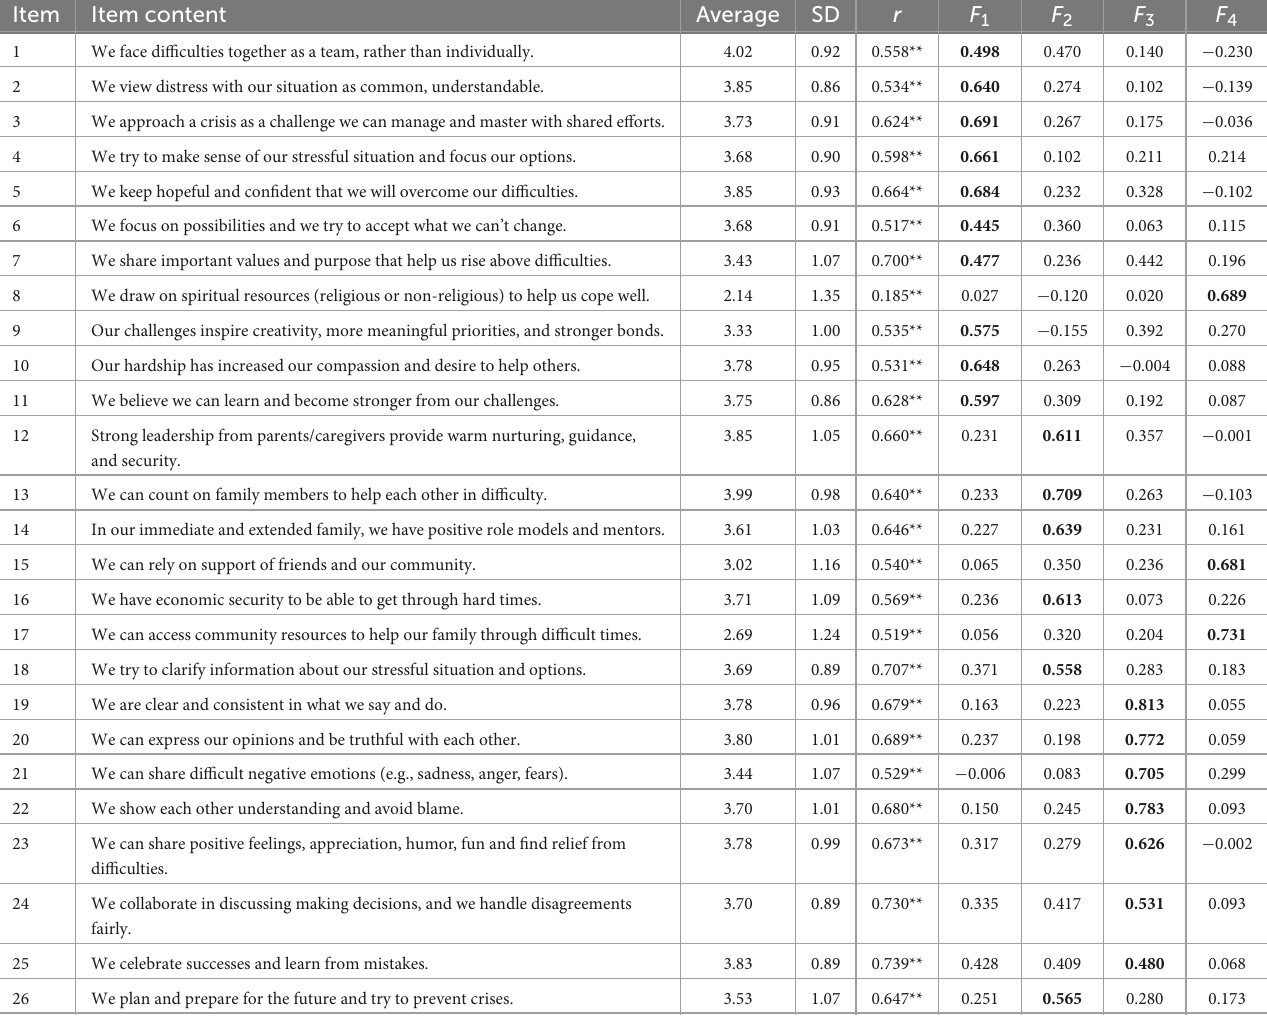
TABLE 2 Walsh Family Resilience Questionnaire among community-dwelling disabled elderly individuals (WFRQ-CE) item-total score correlation analysis results and factor loading ( n = 281). Item Item